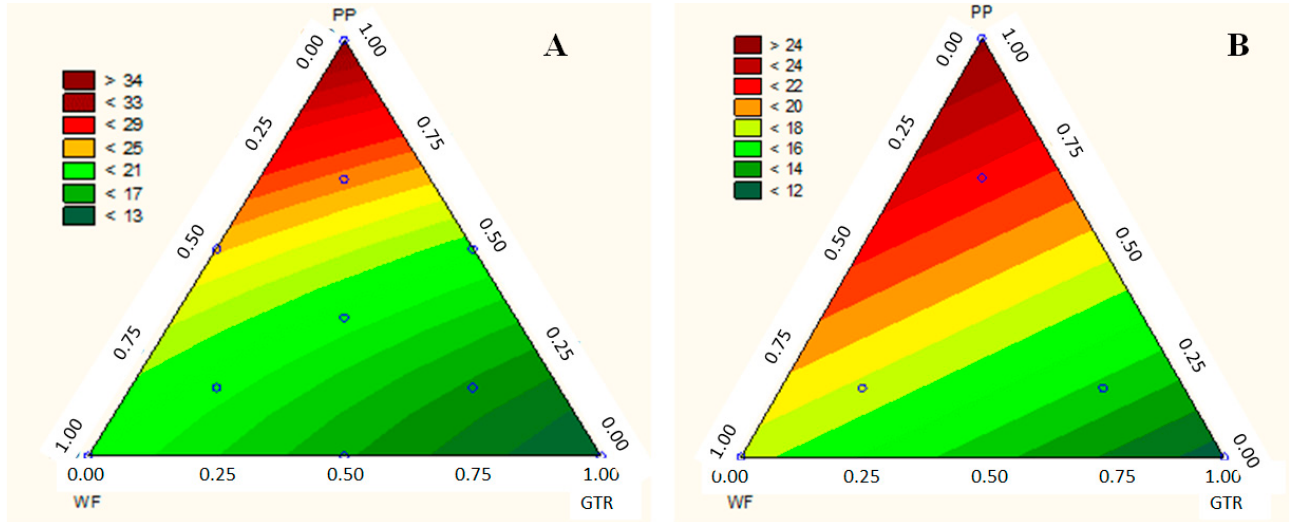
Figure 3. Tensile strength results of the untreated ( A ) and EB compatibilized ( B ) PP/GTR/WF composites.